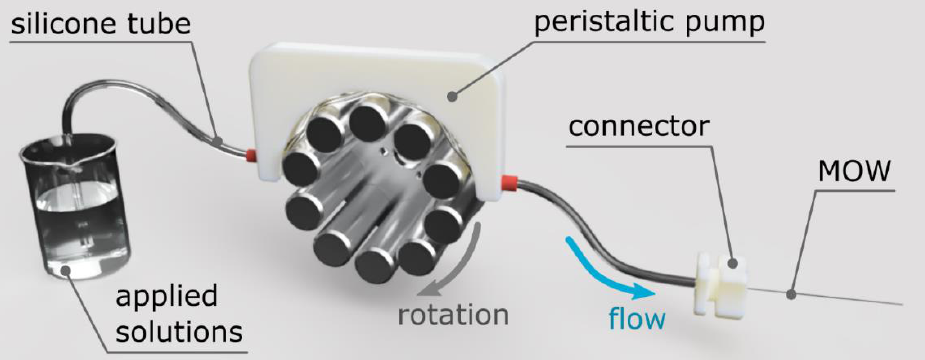
Figure 2. Schematic of the experimental setup for fiber coating.